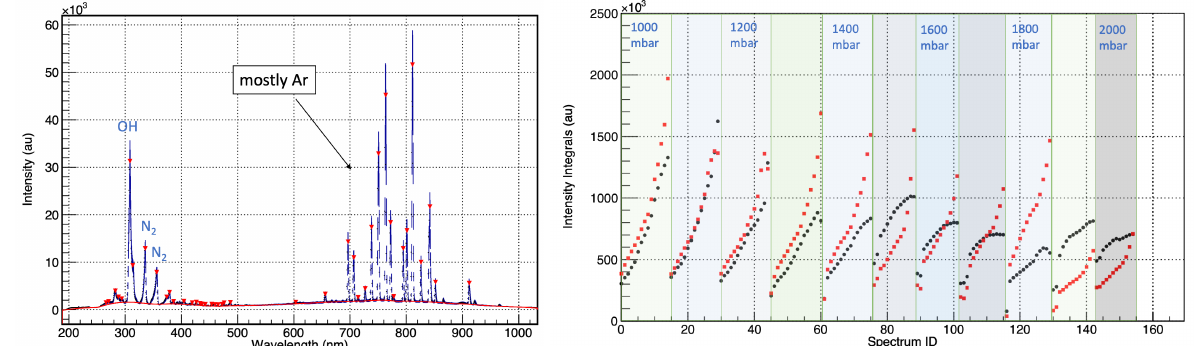
Figure 1. A picture of the light source during operations. The front part of the light source is pictured. The light through the MgF 2 window is visible.